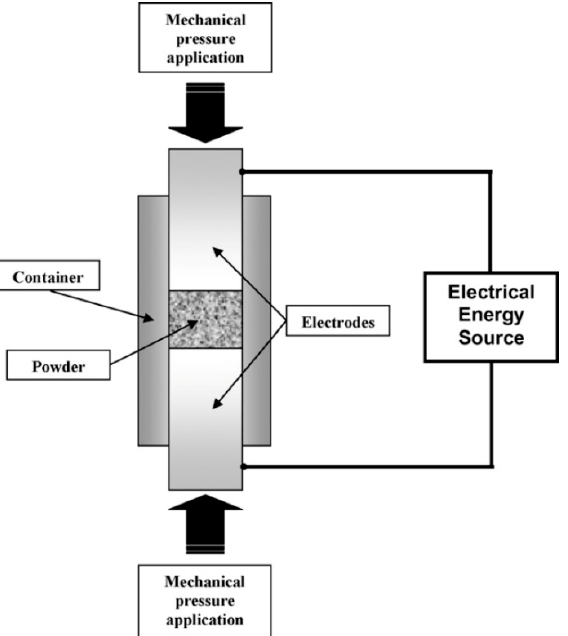
Figure 2. Schematic representation of the SPS process [1]. Reproduced with permission from Materials Science and Engineering: R , published by Elsevier, 2009.